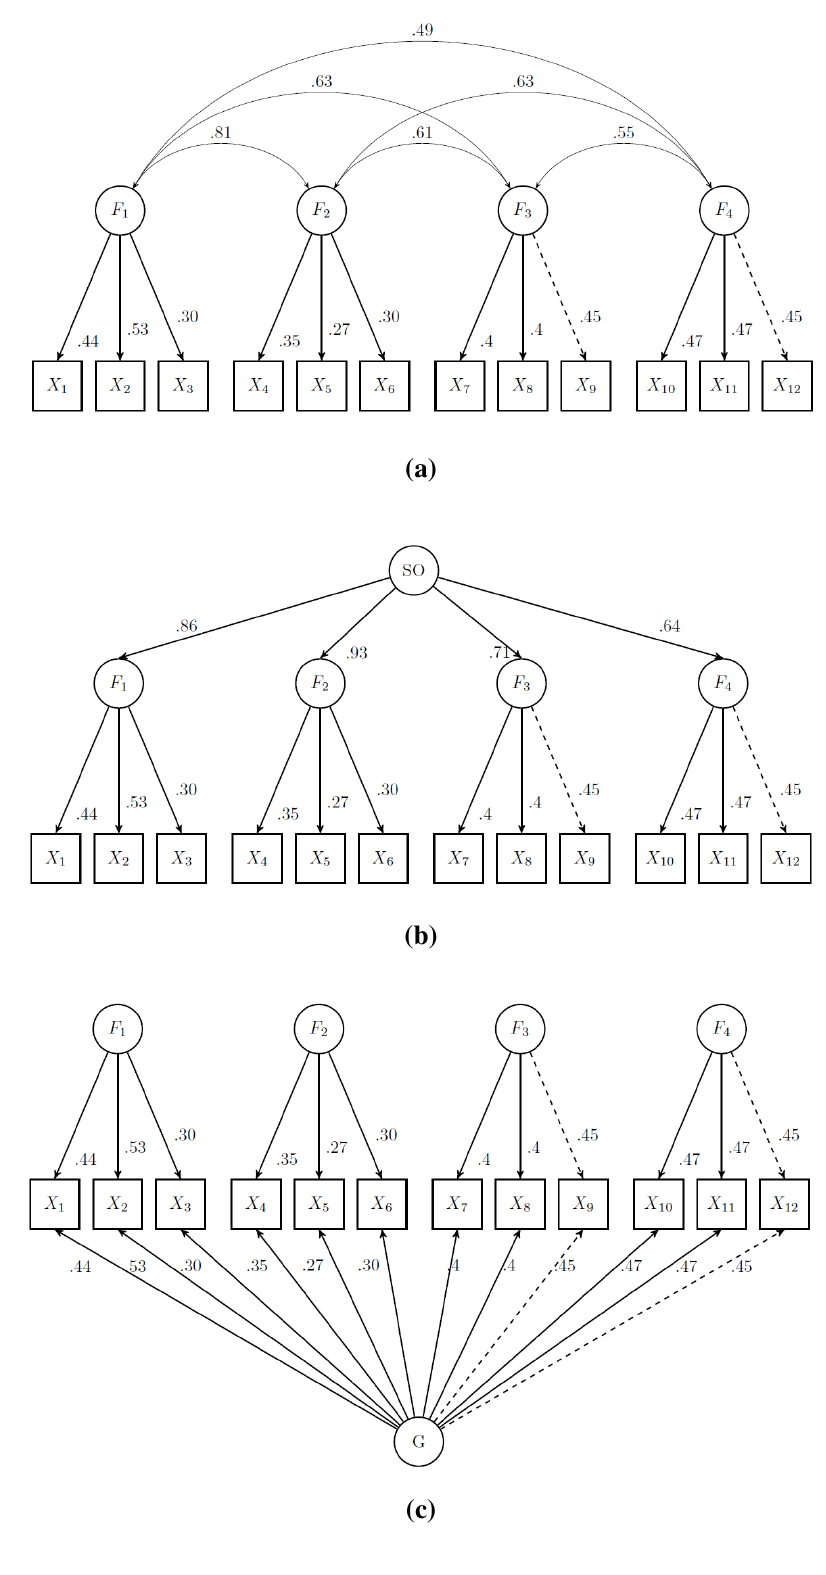
Figure 2. Population models from which random samples were drawn. Solid lines indicate paths that were estimated for all models. Dashed lines indicate paths that were estimated only in the conditions with all four factors being locally just-identified. ( a ) Correlated Factors Model; ( b ) Higher-Order Model; ( c ) Bi-factor